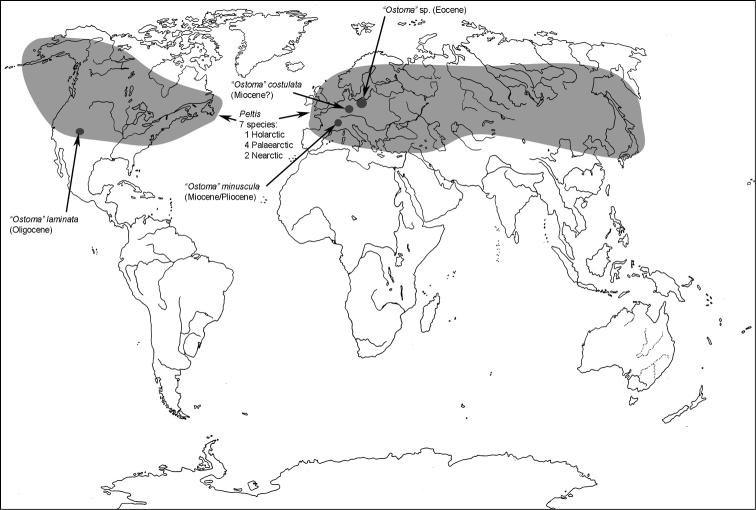
A distribution of the tribe Peltini.